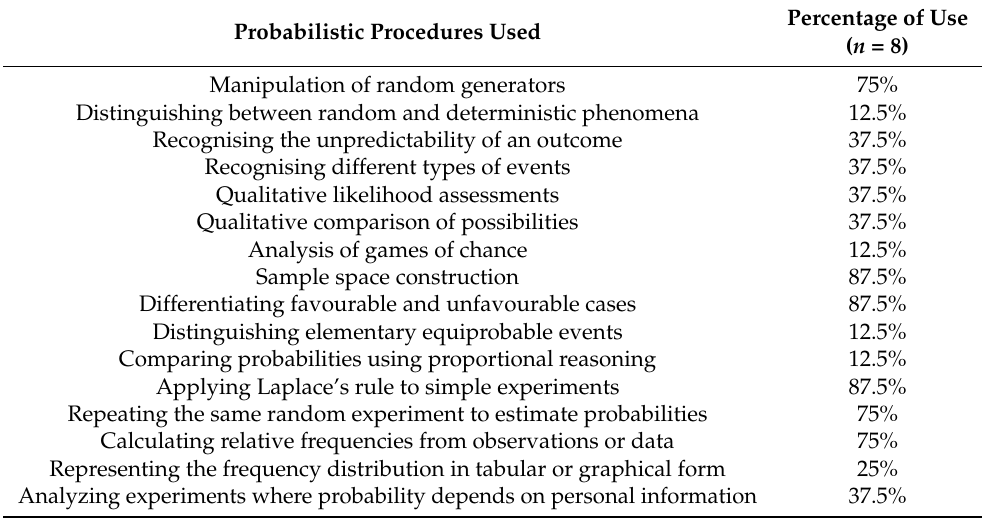
Table 6. Probabilistic procedures used in the tasks.